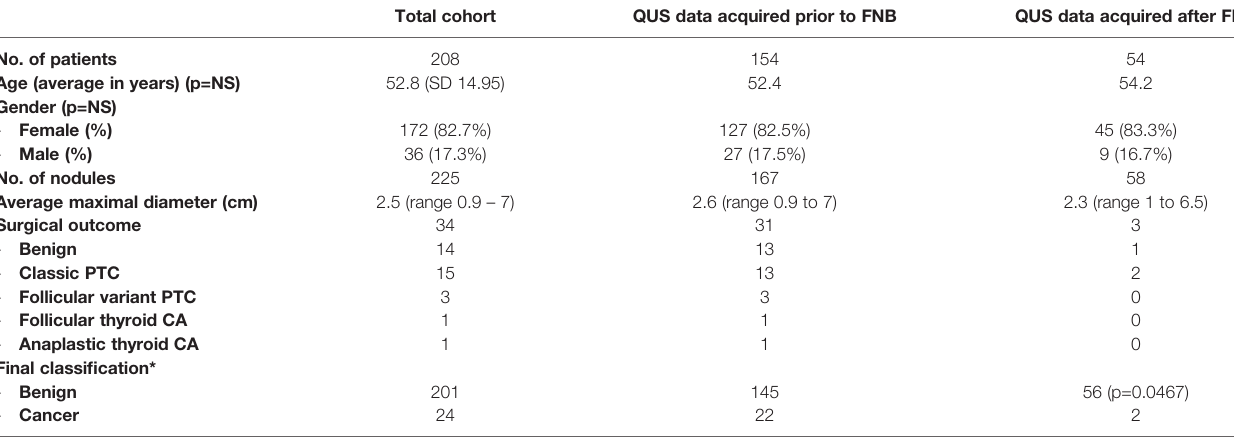
TABLE 1 | Basic demographic data and nodule characteristics.